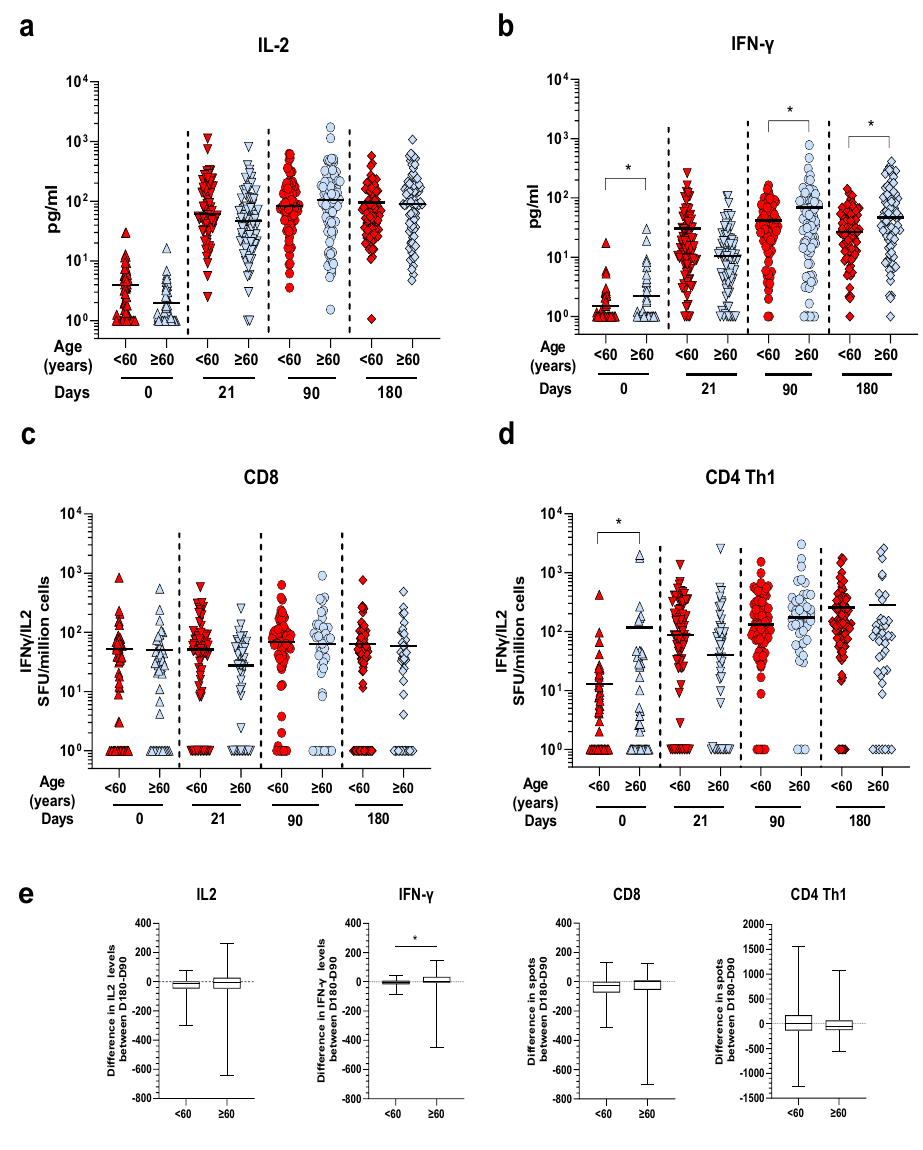
Fig. 6 | Age strati fi cation of T cell responses. Comparison of the T cell response betweenagegroupsofsamplesfromvaccinatedindividualsatdifferenttimepoints post immunization. a IL-2 and b IFN- γ production induced by Spike-peptide pool stimulation from individuals aged <60: ( n =82), and ≥ 60 ( n =75). Mean values are indicated by a dark line. * p <0.01, two-sided Student t -test on normalized log values. c CD8 T cells comparison between the analyzed age groups. Less than 60 group:day0( n =66),day21( n =66),day90( n =66)andday180( n =85),and ≥ 60: day 0 ( n =43), day 21 ( n =44) and day 90 ( n =43) and day 180 ( n =41). Median values are indicated by a dark line. * p <0.01, two-sided Mann – Whitney test on log values. d CD4Th1cellscomparisonbetweentheanalyzedagegroups.Lessthan60 group: day0 ( n =72), day 21( n =72), day 90 ( n =72) and day180 ( n =83),and ≥ 60: